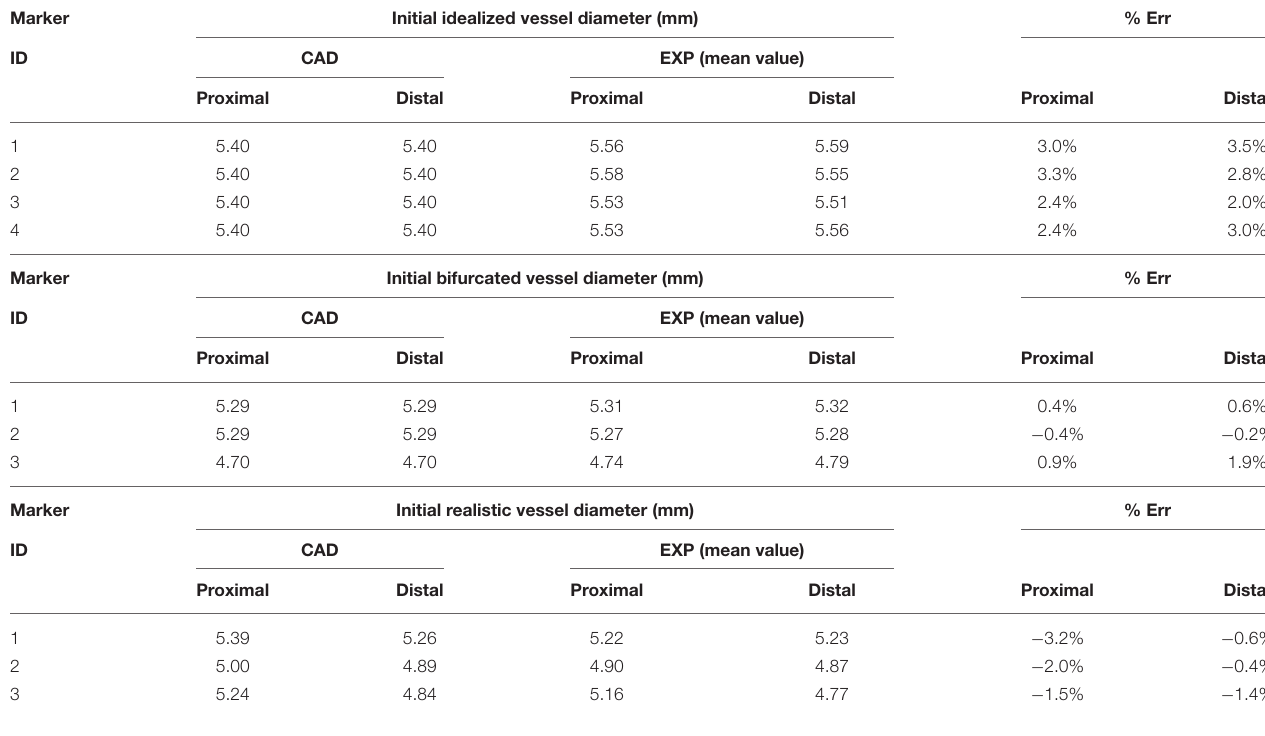
TABLE 1 | Comparison between the initial value of the diameter in the CAD and the real phantom of the idealized, bifurcated, and realistic vessel design.